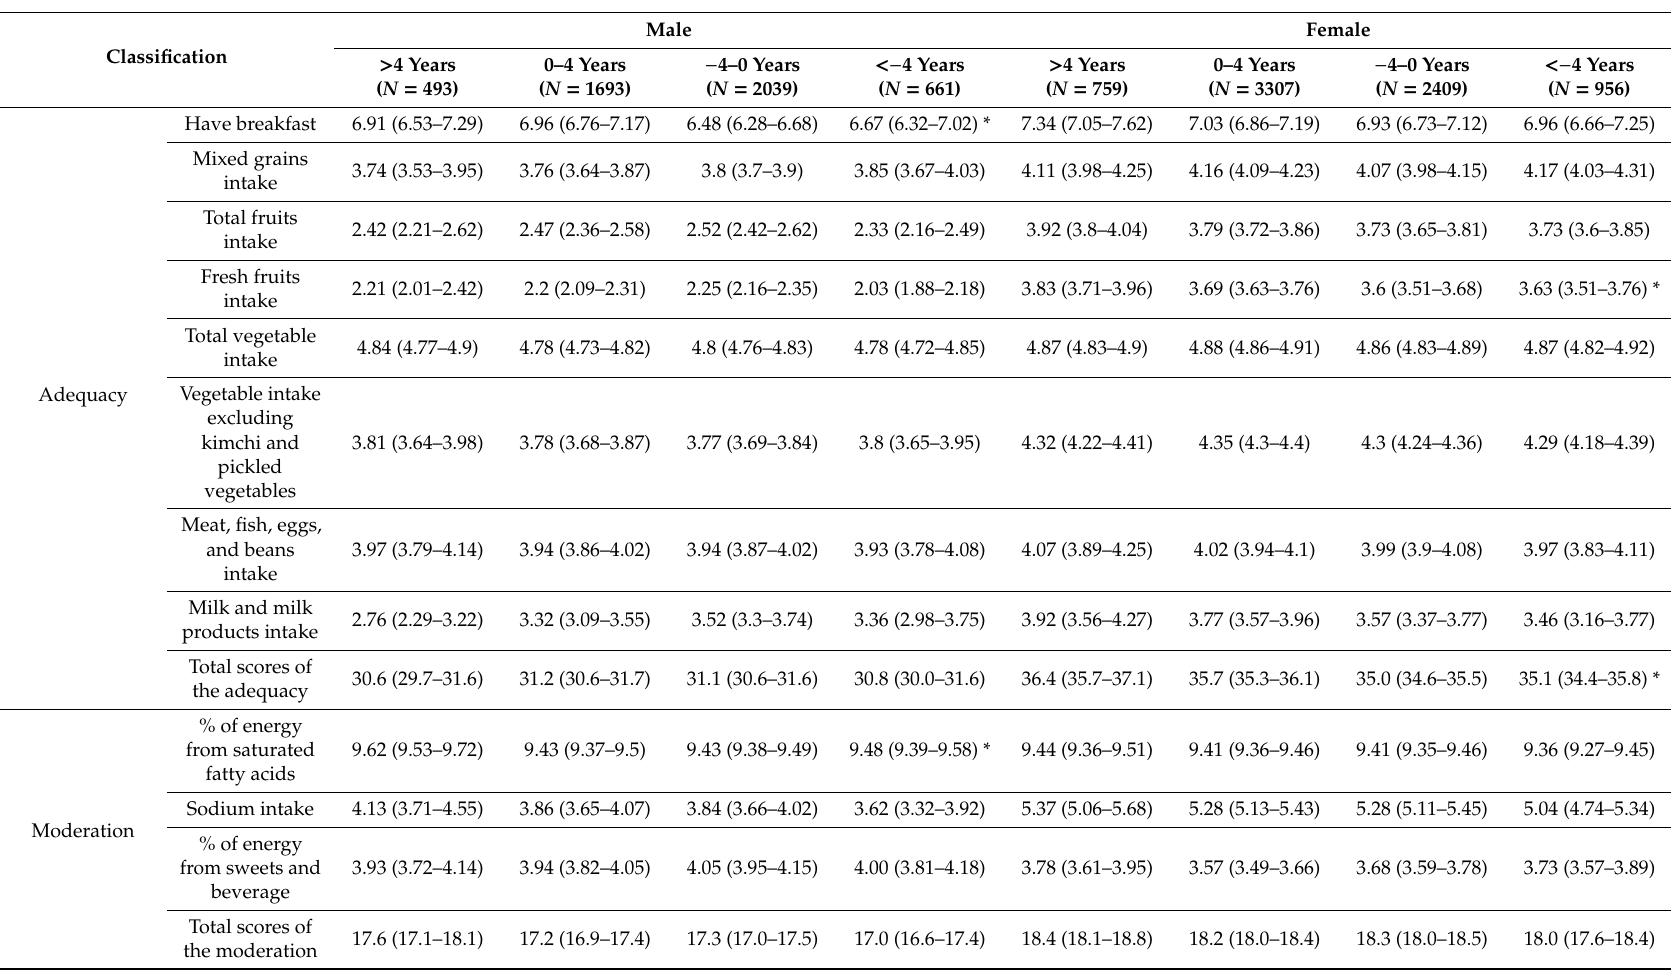
Table 2. Adjusted 1 means and 95% confidence intervals of the Korean Healthy Eating Index Score (KHEI) by the age-gap 2